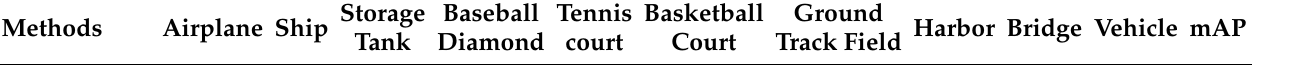
Table 2. Comparison results on NWPU VHR-10. The bolded numbers are the best indicators for each category.